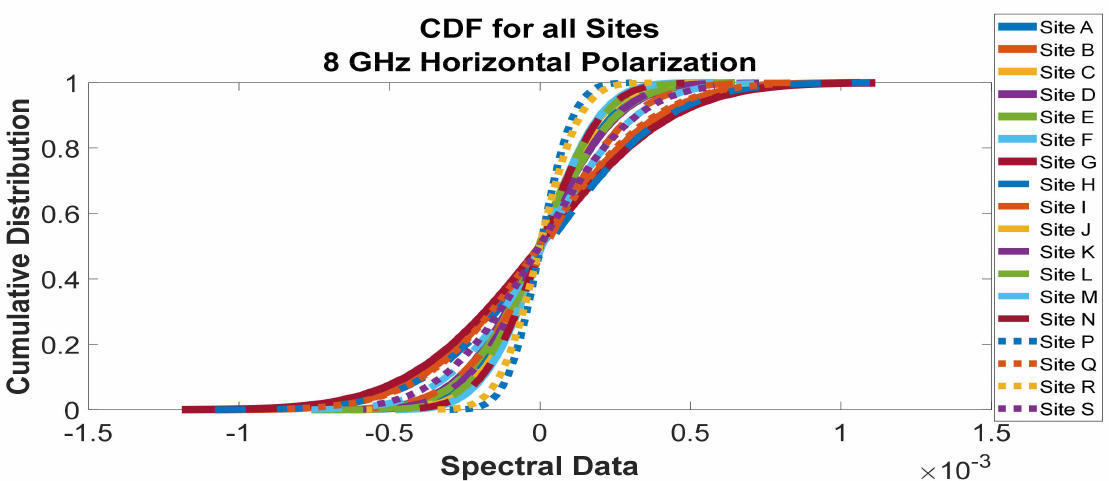
Figure 39. Cumulative distribution functions of frequency scan for all sites at 8 GHz horizontal polarization.